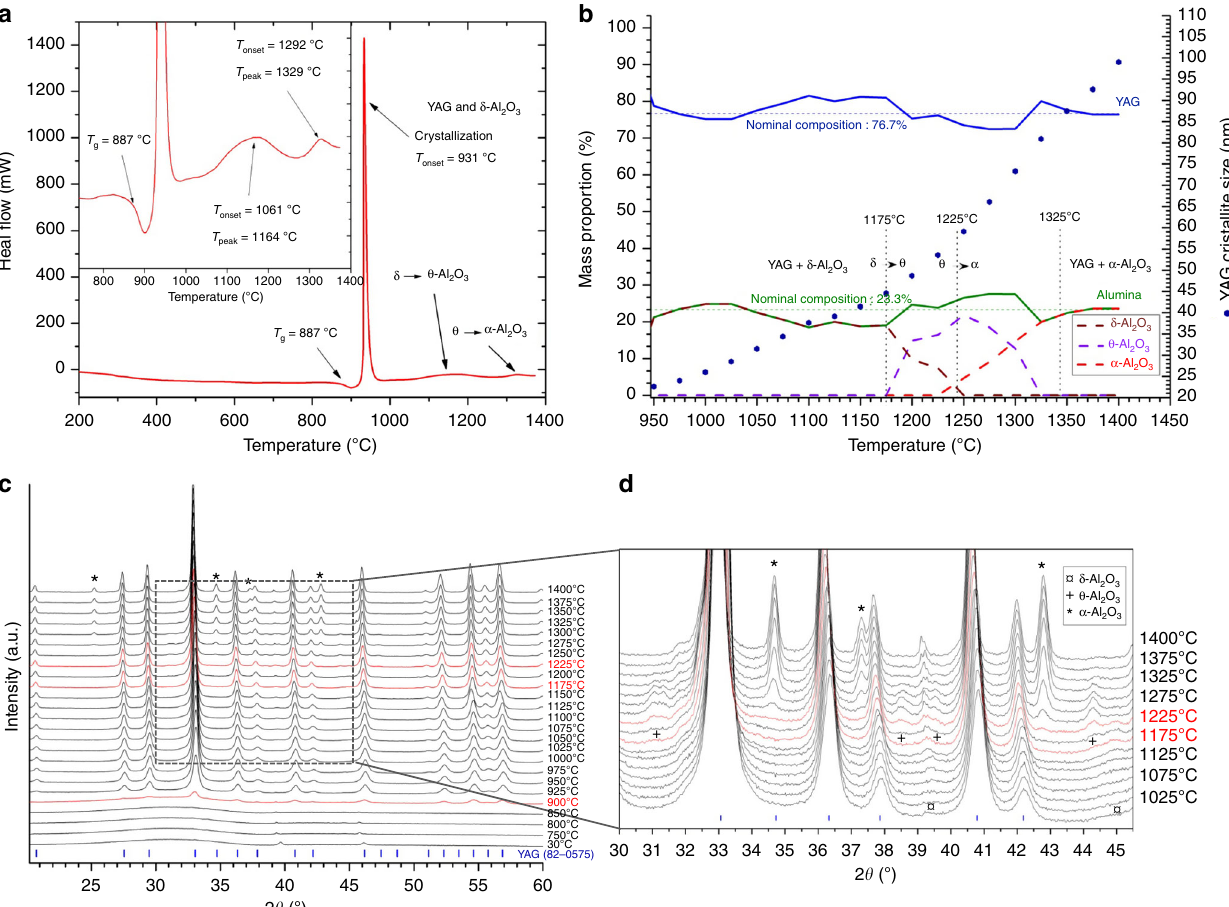
Fig. 2 Crystallization process of the AY26 glass precursor into YAG-Al 2 O 3 composite nanoceramics. a Differential scanning calorimetry measurement of the AY26 glass precursor showing the glass transition at 887±1 °C and a strong exothermic peak corresponding to crystallization of both YAG and δ -Al 2 O 3 phases at 931±1 °C followed by two broad exothermic peaks corresponding to the δ -Al 2 O 3 → θ -Al 2 O 3 ( T onset = 1061 °C; T peak = 1164 °C) and θ -Al 2 O 3 → α - Al 2 O 3 ( T onset = 1292 °C; T peak = 1329 °C) transitions. b Evolution of the YAG and Al 2 O 3 polymorphs contents versus treatment (left vertical axis). The evolution of the crystallite size (right vertical axis) versus temperature is also presented. c In situ X-ray powder diffractograms collected upon heating from the AY26 glass powder sample. The indexation corresponds to the YAG garnet structure (PDF 70-7794). d Enlargement showing the Al 2 O 3